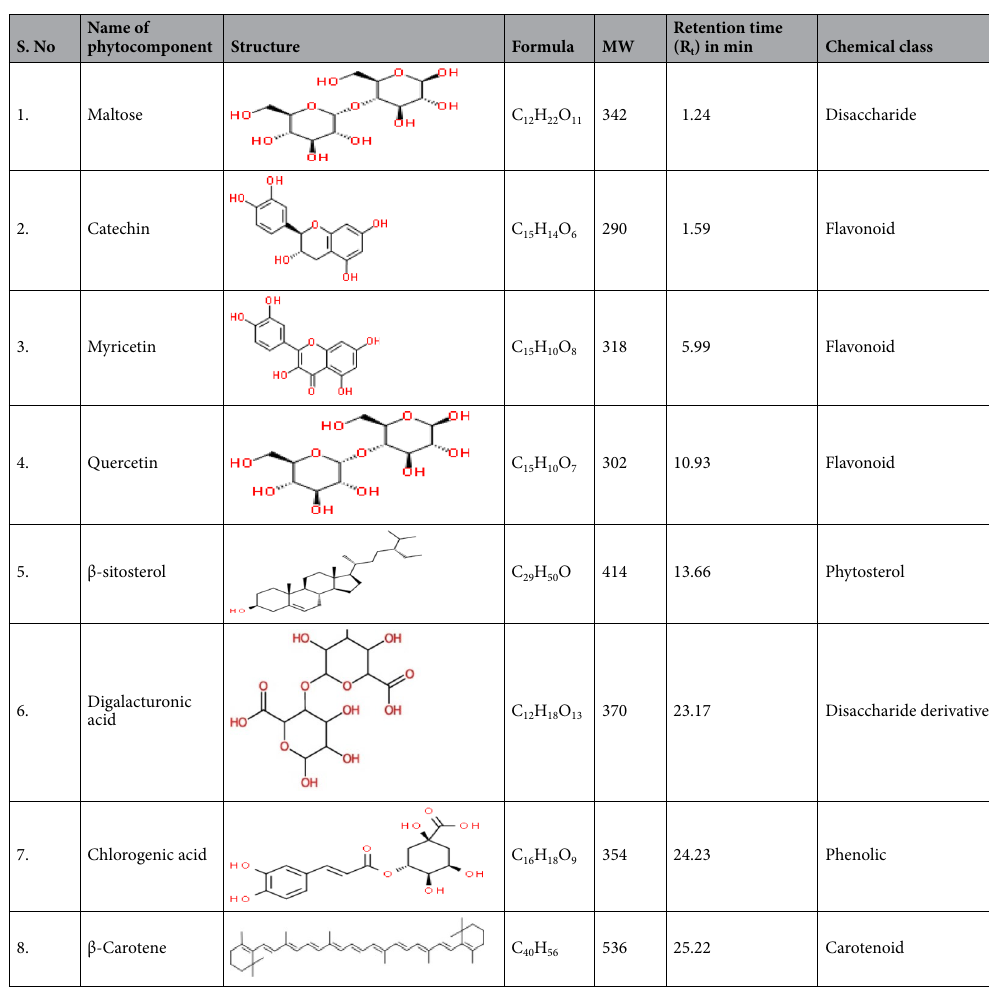
Table 1. Name of phytocomponents, molecular formula, MW and structure of different phytoconstituents identified from ethanolic ADPE using